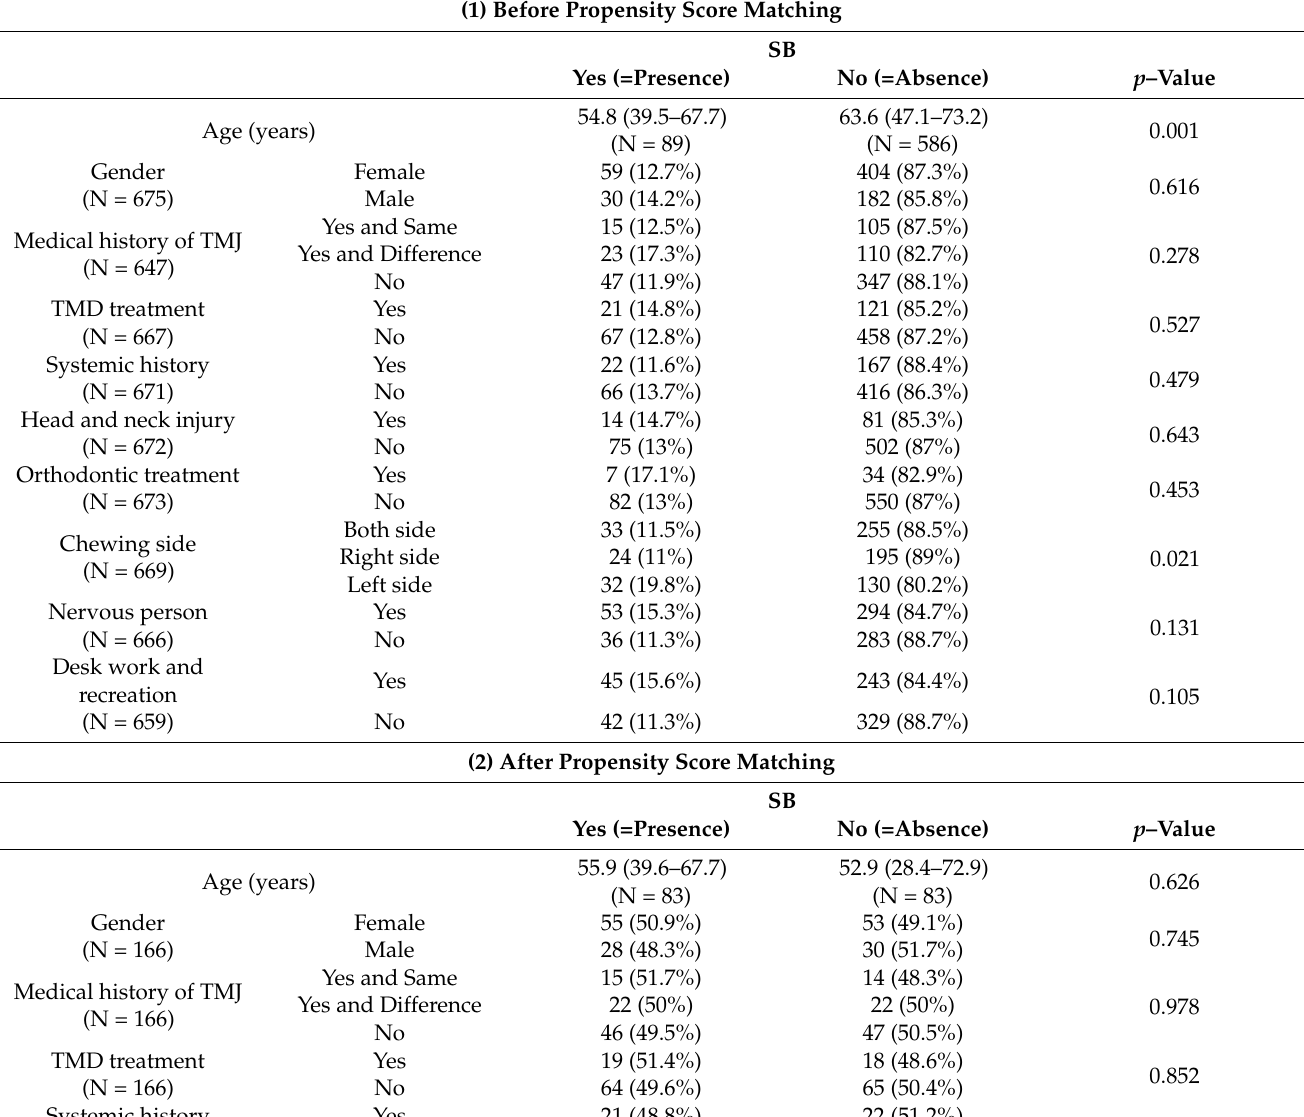
Table 3. Demographic and clinical characteristics of TMD patients with and without SB, in case the other OPFHs and PHs are